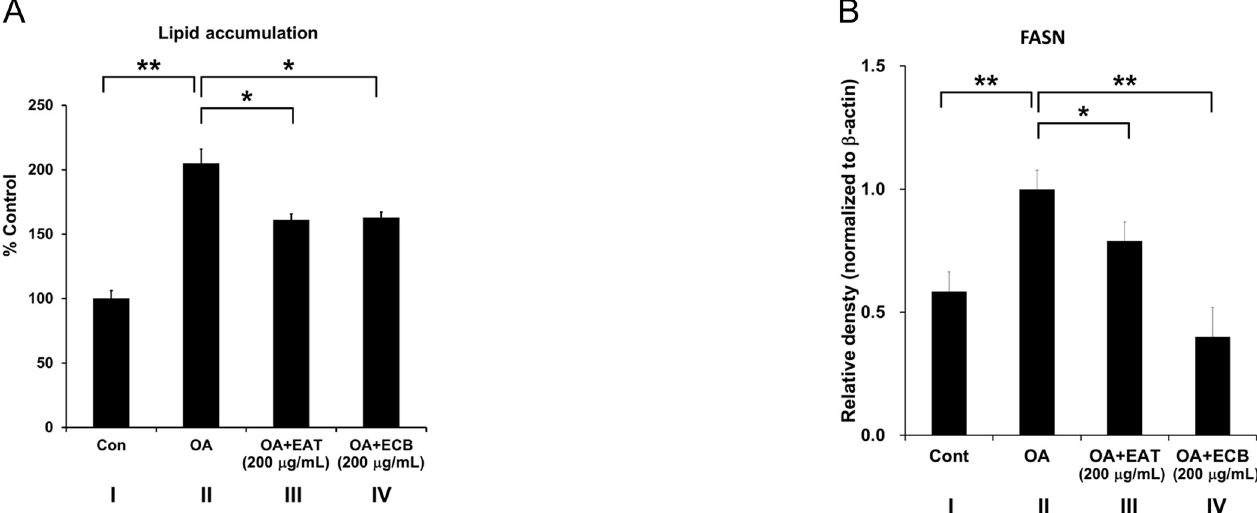
Fig 1. Lipid accumulation and expression of FASN in HepG2 cells. (A) Effects of ECB or EAT treatment on lipid accumulation in OA-induced hepatic steatosis. HepG2 cells were stimulated with 0.5 mM OA (II), OA with EAT (200 μ g/mL, III) and OA with ECB (200 μ g/mL, IV) for 24 h. Oil red O dye as fat drops were quantified (n = 3, I and II; n = 4, III and IV). (B) FASN expression was calculated using ImageJ (n = 6, I and II; n = 4, III and IV). Data was shown as mean ± SD. �� : p < 0.01, � : p < 0.05.